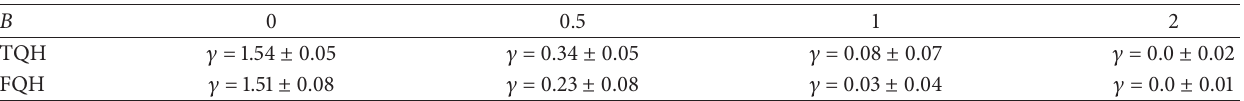
Figure 3: Finite size analysis of structures for TQH using different external field strengths. In all figures we used 𝑝 = 0.1 , 𝑊 = 3 , 𝑇 = 0.5 , and 𝐿 = 70 . (a) SRO: 𝛾 = 1.54 ± 0.05 and 𝐵 = 0 ; (b) QLRO: 𝛾 = 0.34 ± 0.05 and 𝐵 = 0.5 ; (c) LRO: 𝛾 = 0.0 ± 0.02 and 𝐵 = 1.5 . Table 1: Finite size analysis data obtained from (A.2). Values of 𝛾 reveal range of order within nematic structures. We used different histories of samples (FQH and TQH) and different values of the external field 𝐵 . Values 𝛾 = 0 , 0 < 𝛾 < 1.5 , and 𝛾 = 1.5 reveal LRO, QLRO, and SRO, respectively. 𝑊 = 3 , 𝑝 = 0.1 , and 𝑇 = 0.5